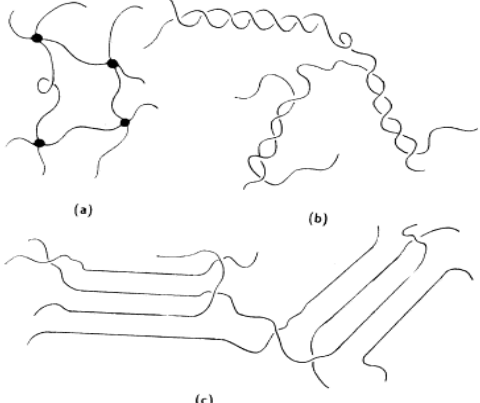
Figure 10. Schematic representation of ( a ) a chemical gel network with junction points; ( b ) physical gel networks having junction zones and ( c ) fringed micelles, respectively